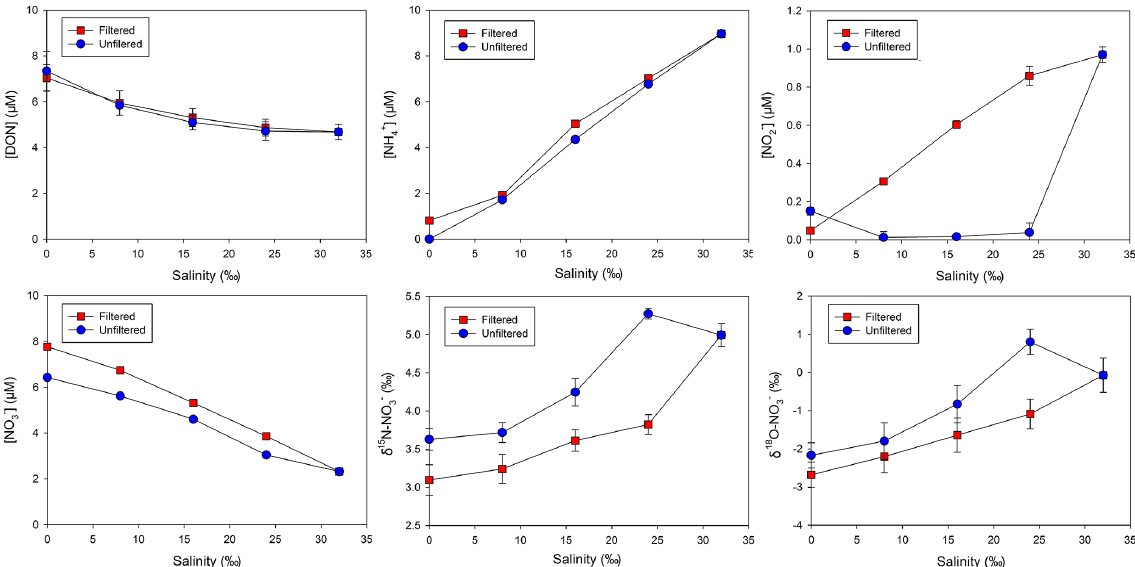
Figure 6. Concentrations of DON, NO − deviation).